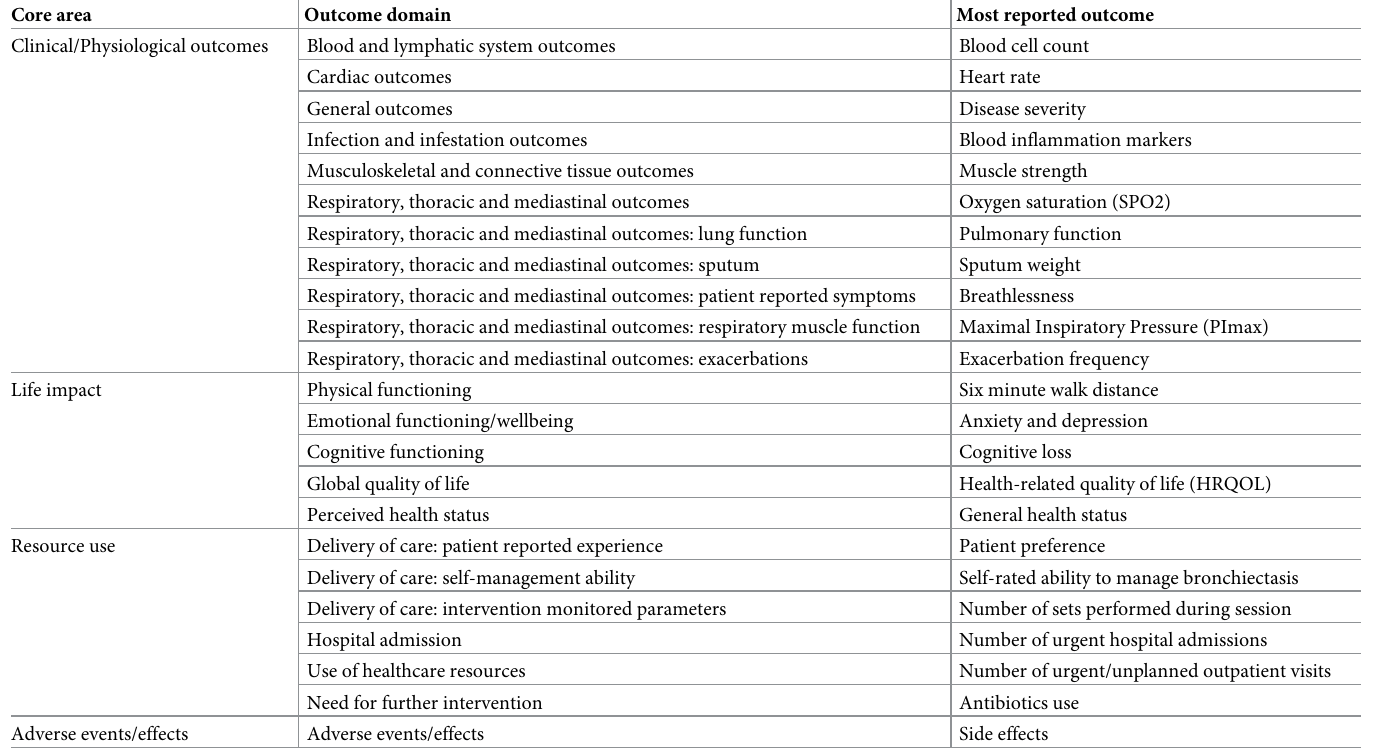
Table 3. Classification of outcomes, adapted from COMET taxonomy